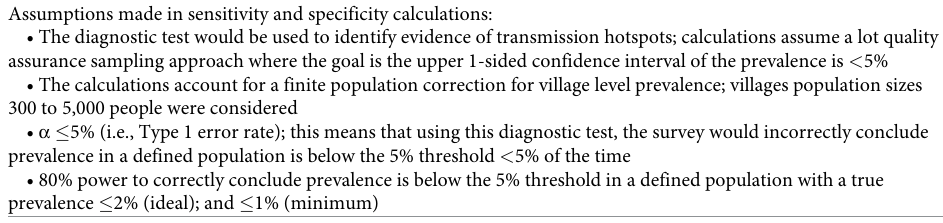
Table 2. Parameters and assumptions for use case 2: